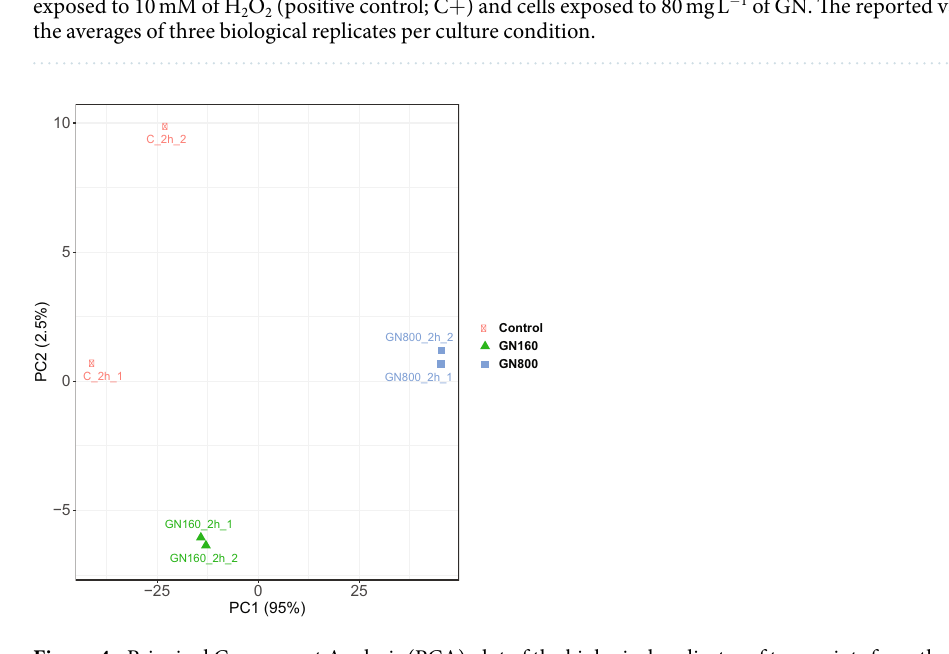
Figure 4. Principal Component Analysis (PCA) plot of the biological replicates of transcripts from three different exposure conditions to polycarboxylate functionalized graphene nanoplatelets (non-exposed, 160 mg L − 1 and 800 mg L − 1